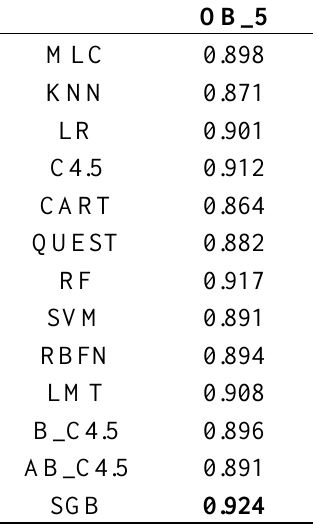
Table 5. Best classification accuracy for each algorithm using objected-oriented